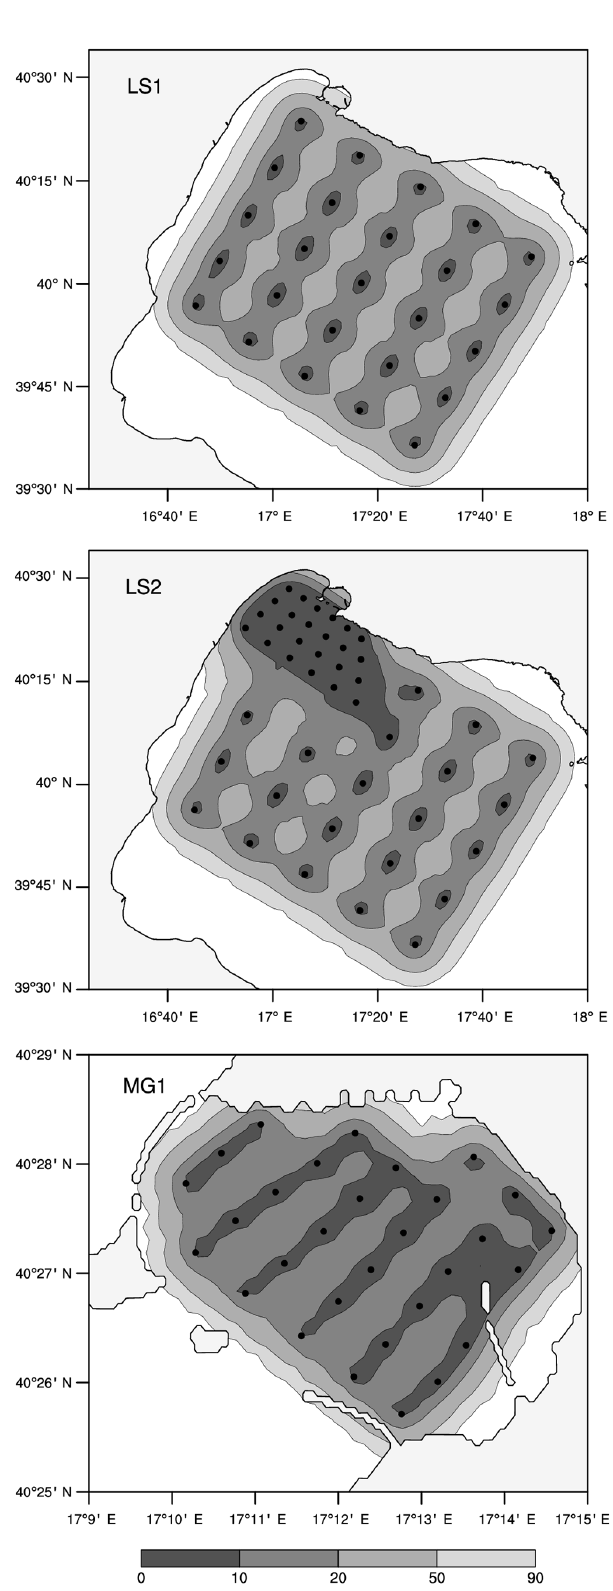
Figure A1. Objective analysis percentage error field for the three surveys using the parameters of Table A1 (units are %).